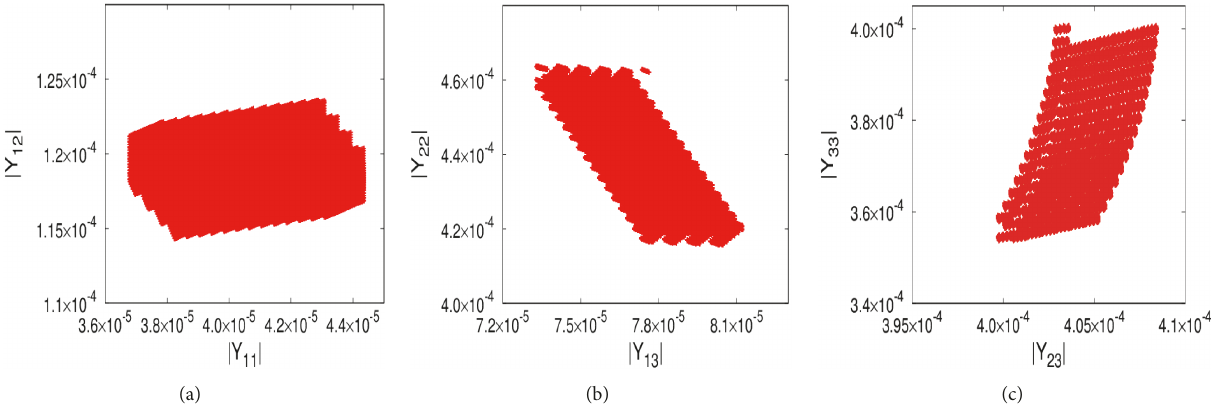
Figure 5: Determination of moduli of 𝑌 matrix elements for a fixed value of lightest mass eigenvalue 𝑚 1 = 0.00127 eV. Phase angles used for computation are 𝛼 푀 = 124.37 ∘ , 𝛽 푀 = 86.27 ∘ (randomly chosen), and 𝛿 = 216 ∘ . Neutrino oscillation observables are varied within 1𝜎 range.